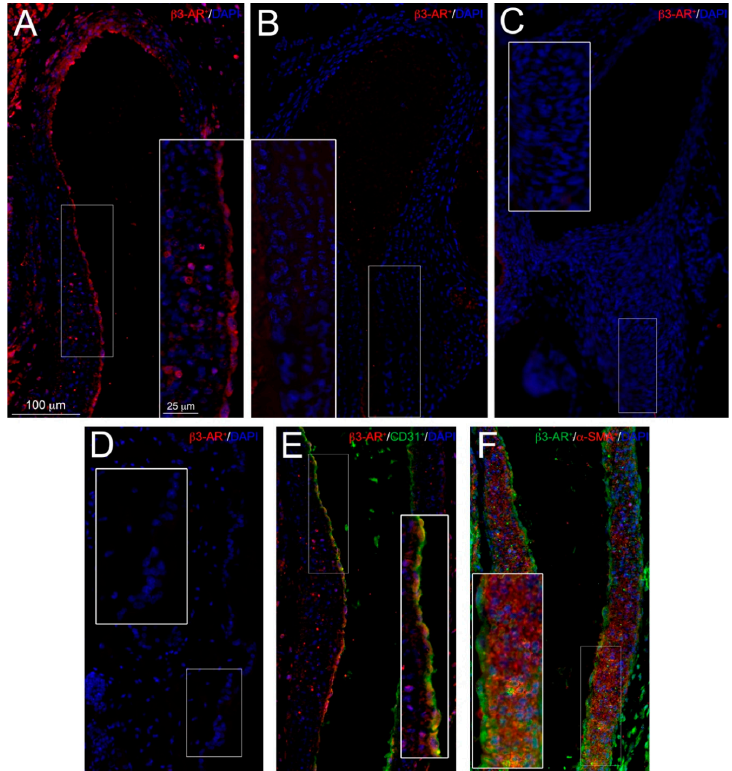
Figure 3. Immunofluorescent staining of β 3-AR on the ductus arteriosus (DA). Panel ( A ) β 3-AR (red) labeling on DA of prenatal fetuses; Panels ( B , C ) β 3-AR (red) labeling on DA of newborn mice 1 h and 7 h after delivery, respectively; Panel ( D ) β 3-AR (red) labeling is absent on epidermis (negative control); Panel ( E , F ) CD31 (green) / β 3-AR (red) and α -SMA (red) / β 3-AR (green) double labeling, respectively, on DA of prenatal fetuses; CD31 / β 3-AR and α -SMA / β 3-AR positive cells can be seen in the tunica intima and tunica media of the DA. Nuclei are blue stained with DAPI. Scale bars are indicated in panel A. Results are representative of three independent